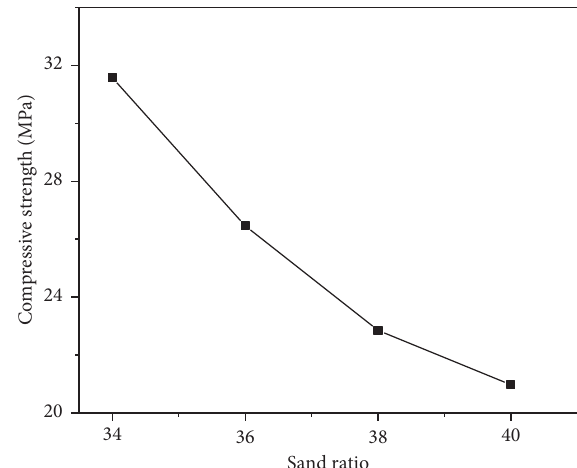
Figure 7: The impact of the sand ratio on the compressive strength of the FSSAC.